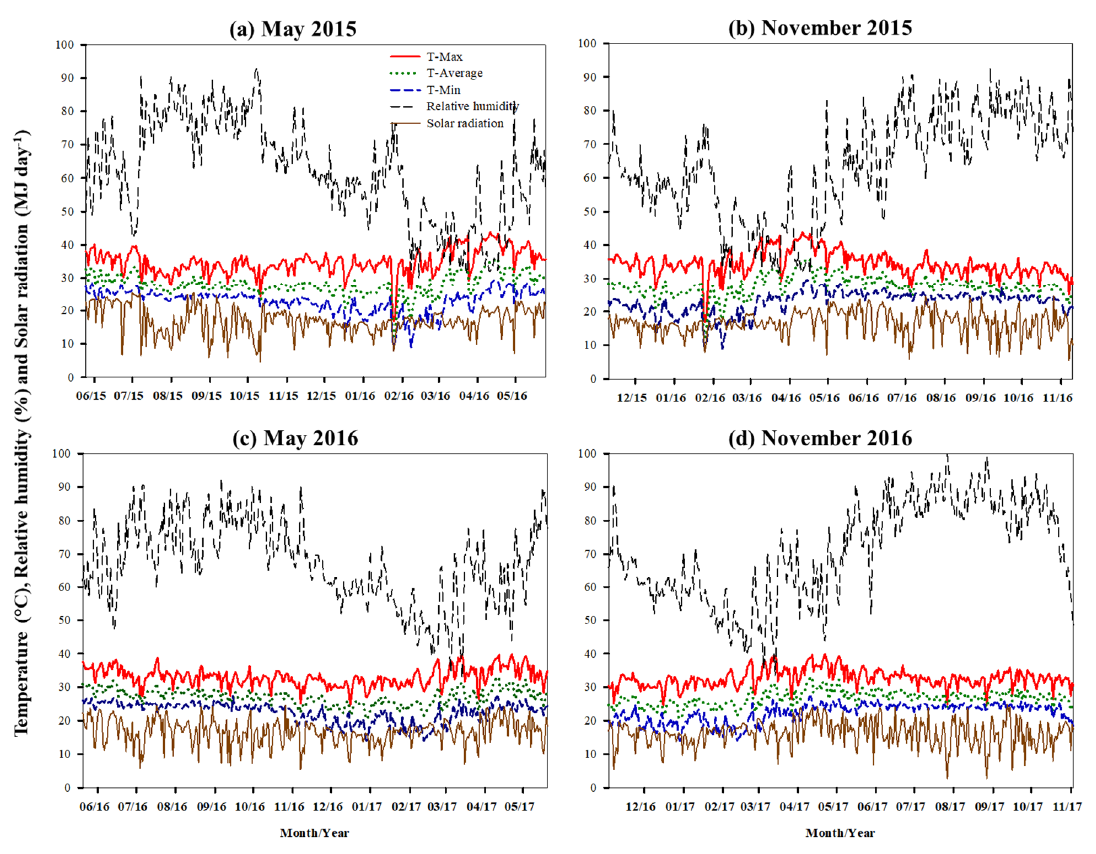
Figure 1. Minimum ( —– ), maximum ( — ) and average ( ····· ) temperatures, relative humidity ( − − − ) and solar radiation ( −−− ) in May ( a ) and November ( b ) 2015, and May ( c ) and November ( d ) 2016. 3.3. Biomass (BM), Storage Root Yield (SRY), Starch Content (SC) and Harvest Index (HI) At final harvest, years were significantly different for most traits except for SRY (Table 2). Planting dates were significantly different ( p ≤ 0.01) for all traits. The interactions between years and planting dates were not significant for most traits except for SC and HI. Significant differences among cassava genotypes were observed for all traits. The interactions between year and genotype were not significant for most traits except shoot DW and SC. The interactions between planting date and genotype were significant for most traits except for shoot DW. The interactions among year, planting date and genotype were not significant for most traits, except SC (Table 2). Year contributed to the largest portions of total variations in shoot DW (66.5%) and HI (52.0%), but it had small contributions to BM (11.4%), storage root DW (10.7%), SC (11.4%) and SRY (2.4%). Planting date contributed to the largest portions of total variations in BM (51.5%), storage root DW (36.0%) and SRY (42.2%), but it had low contributions to shoot DW (12.7%), HI (4.7%) and SC (11.0%) (Table 2). Genotype contributed the largest portion of the total variation in SC (26.4%), but it had a small contribution to BM (4.7%), storage root DW (11.5%), shoot DW (2.3%), HI (11.6%) and SRY (6.8%). The interaction between genotype and planting date had moderate contribution to storage root DW (16.0%) and SRY (19.6%). The interaction between years, planting dates and genotype contributed to variability. In general, BM and shoot DW in 2015 were higher than in 2016, but storage root DW, HI and SC in 2016 were higher than 2015. Planting in the same month, SRY between 2015 and 2016 was not significant difference (Figure 2). The interaction between planting date and years were not significant for BM, storage root DW, shoot DW and SRY. The results showed that the crop planted in November had higher BM, shoot DW, storage root DW and SRY than the crop planted in May for both years.